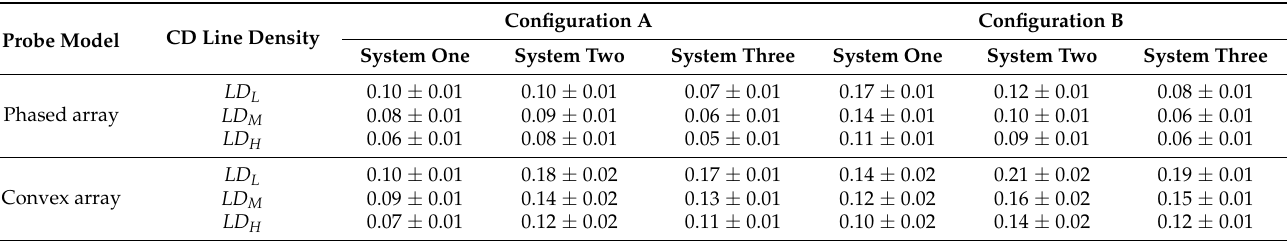
Table 13. Temporal resolution parameter results (mean ±